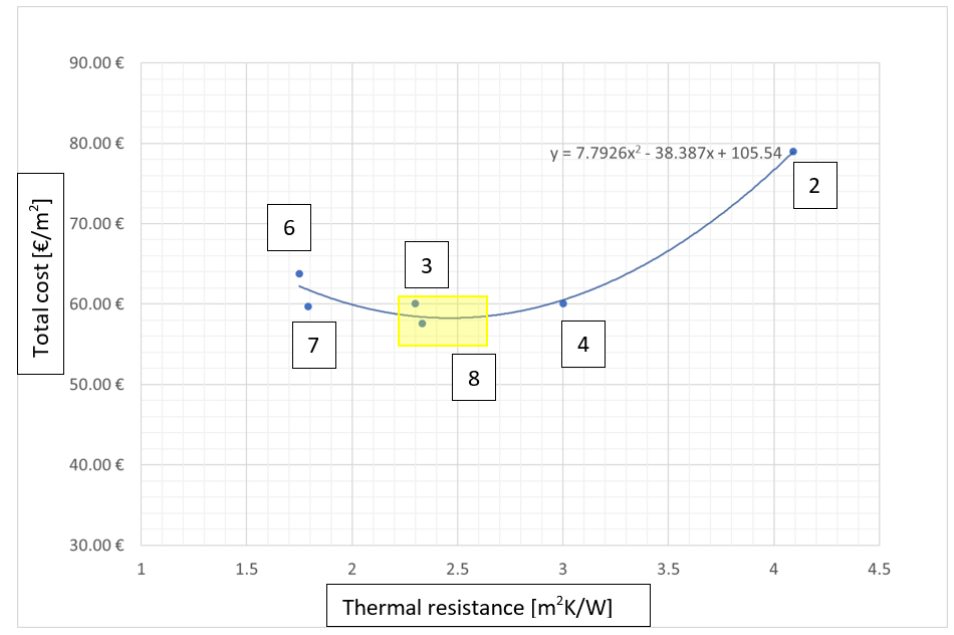
Figure 10. Total cost of the heat-reflective materials (numbered in the squares) with the correspondent thermal resistance. Approximation of the results with a second-degree polynomial equation. From this starting point, the materials falling on the left of the yellow region have to be discarded because they provide a lower thermal resistance and require a higher total